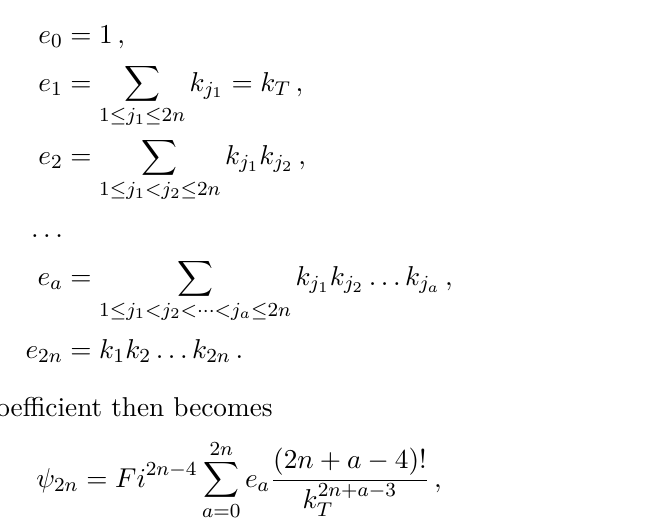
from the exchange of the same scalar in the s - 4